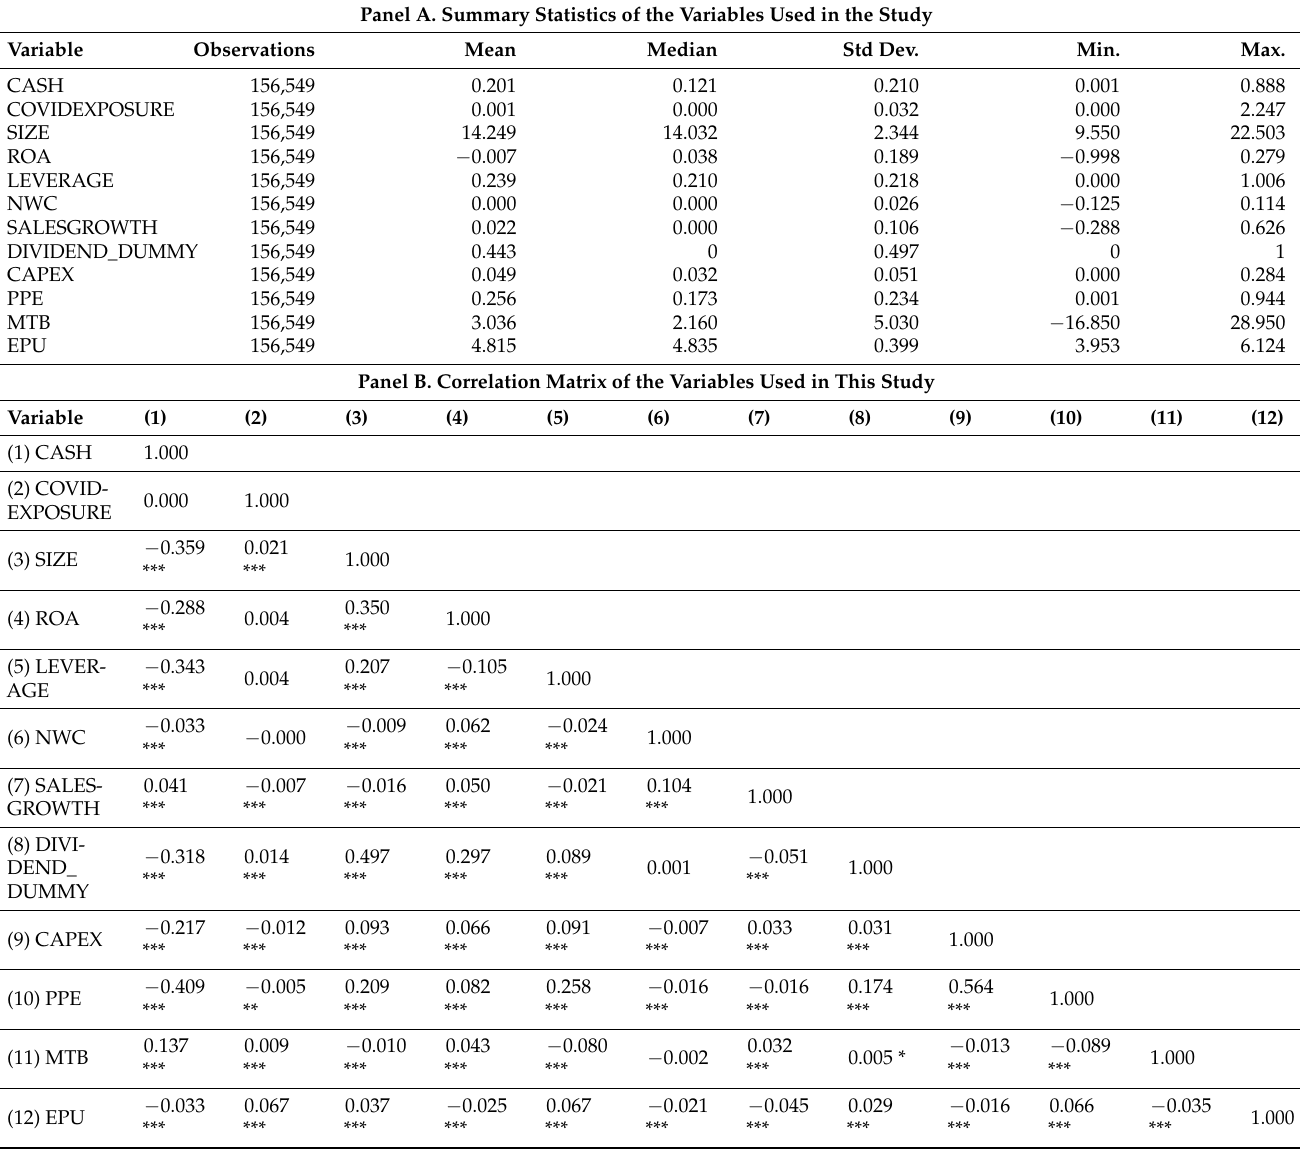
Table 3. Summary statistics and correlation